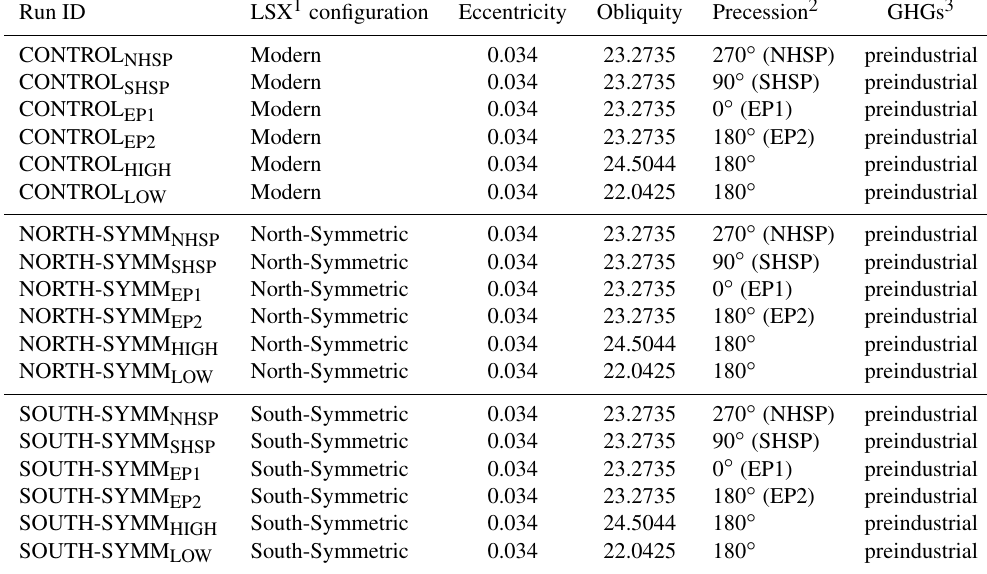
Table 1. Experimental setup of model boundary conditions and